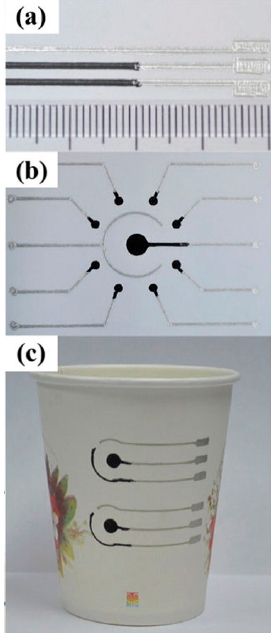
Figure 8. Photographs of electrochemical PADs built up on: A4 papers ( a , b ); and paper cups ( c ).